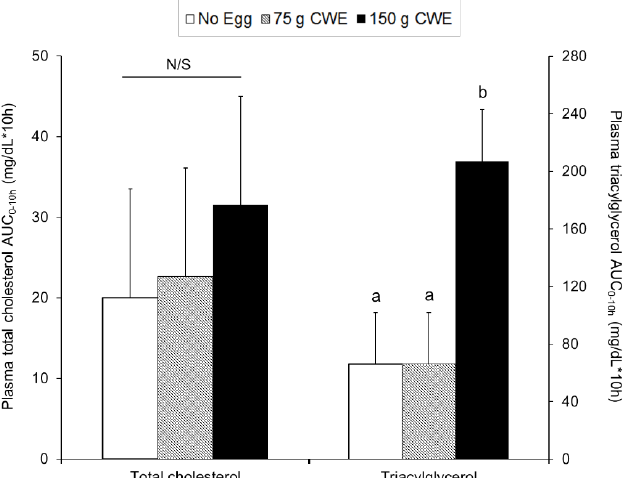
Figure 4. Total cholesterol and triacylglycerol AUC 0 – 10h within plasma in study 1. Values are lsmean ± SE and different superscript letters (a, b) indicate statistical differences among no egg, 75 g CWE, and 150 g CWE treatments ( p = 0.0099). AUC, areas under the curve; CWE, cooked whole egg; N/S, not significant.